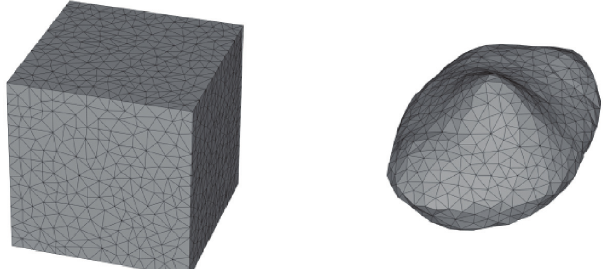
Fig 1. Example particle shapes considered in this work. The Gaussian random ellipsoid (right), which is based on a normal ellipsoid with axis ratios 1:0.8:0.4, has a standard deviation of 0.125 and a correlation length